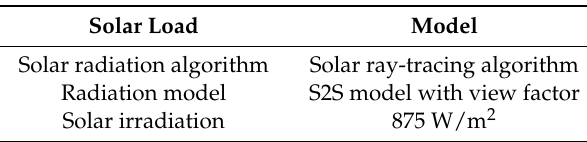
Table 1. Solar Load and Radiation